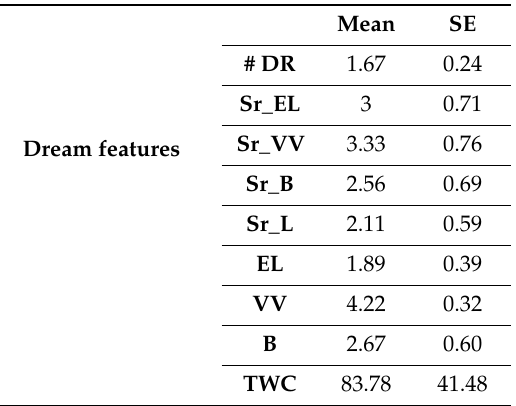
Figure 3. Activation index. Topographic distribution of the activation index, defined as the delta / beta ratio, for the last 5 min of NREM sleep (1st row) and the total NREM sleep (2nd row) in the non-recall (NREC, 1st column) and the recall (REC, 2nd column) groups. The maps are scaled between the minimal and maximal, considering both groups. Statistical maps of the comparisons (unpaired t -test) between the REC and NREC groups are also plotted (3rd column) both for the pre-awakening and the total NREM sleep. The statistical maps are scaled symmetrically according to the absolute maximal t -value across the statistical comparisons. Significant di ff erences after the Bonferroni correction for multiple comparisons are found only for the total NREM sleep and are indicated by white dots ( p ≤ 0.028). Table 2. Means and standard errors (SEs) of the dream features. # DR, number of dreams; Sr_EL, Sr_L, self-reported length; EL, emotional load; VV, visual vividness; B, bizarreness; TWC, total word count, #,